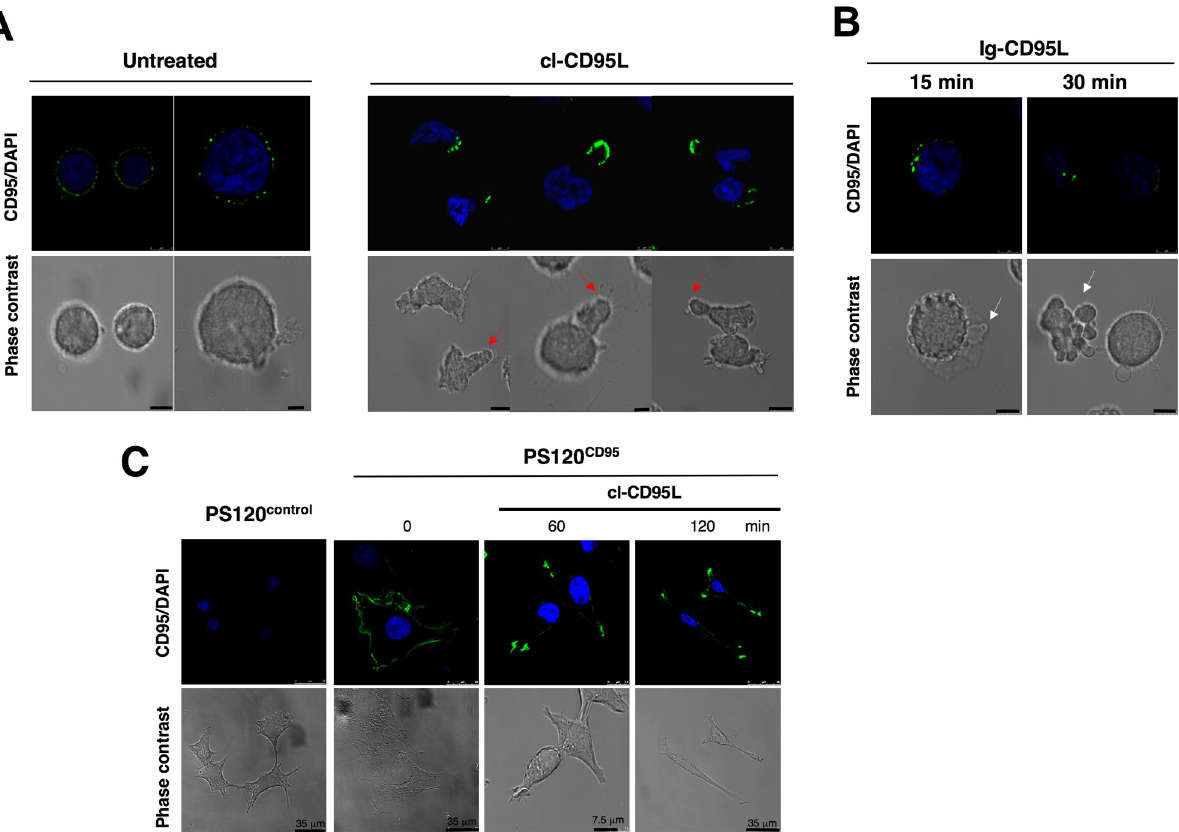
Fig 1. Cl-CD95L elicits CD95-CAP formation. (A) Activated (PHA/IL2)-peripheral blood T-lymphocytes (PBLs) from healthy individuals were incubated with control medium (untreated condition corresponding to the incubation with supernatant of pcDNA3.1(+)-transfected HEK cells) or 100 ng/ml of cl-CD95L for 30 min. Cell morphology was followed using phase contrast microscopy and CD95 was stained using a mouse anti-CD95 mAb (APO1-3) followed by a goat Alexa488-coupled anti-mouse IgG mAb. Red arrows depict emitted pseudopods (Bars = 5 mm). (B) PHA/IL2-activated PBLs were incubated with the cytotoxic Ig-CD95L for indicated times, and cells were analyzed as described in (A). White arrows depict blebs emitted by apoptotic cells (bars = 5 mm). (C) The fibroblastic cell line PS120 devoid of endogenous CD95 (wild type NHE1-reconstituted PS120 control ) or reconstituted with human wild type CD95 (PS120 CD95 ) were untreated or treated with 100 ng/ml of cleaved CD95L for indicated times, and cell shape and CD95 distribution were analyzed. The “0” condition indicates cells analyzed before the addition of 100 ng/mL of